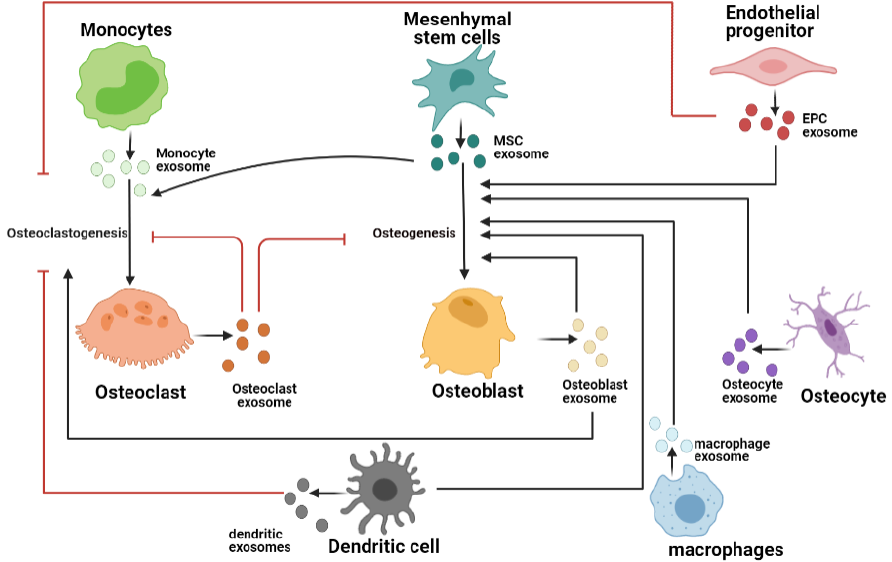
Figure 2. Schematic representation depicting selected role of exosomes from resident and microenvironment cells in bone remodeling: Hematopoietic precursors such as monocytes secrete exosomes, which stimulate osteoclast differentiation. Mature osteoclast-derived exosomes are enriched with RANK, which competitively inhibits osteoclastogenesis while also inhibiting osteogenesis in early stages. Mesenchymal stem cells secrete exosomes, which promote osteogenesis. MSCs and osteoblasts also secrete RANKL enriched exosomes, which stimulates osteoclastogenesis. Osteoblast-derived exosomes further promote mineralization and osteogenesis. Terminally differentiated osteocytes derived from sub population of osteoblasts promote bone formation under mechanical stress conditions. Cells in microenvironments such as endothelial cells and dendritic cells promote bone formation while inhibiting bone resorption. Macrophages also undergo polarization to stimulate osteogenesis.